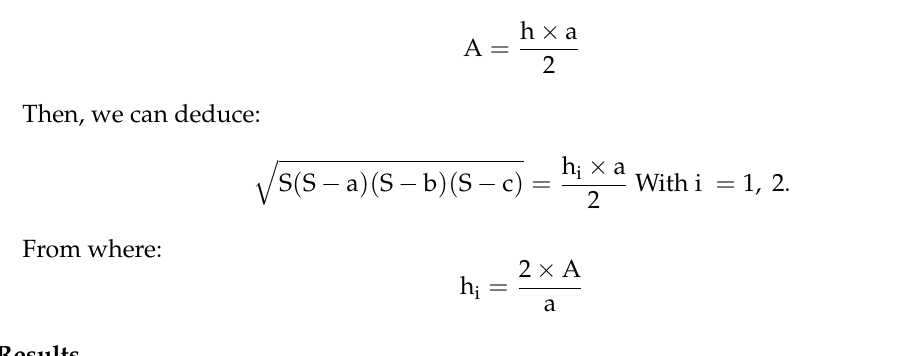
( b ) Figure 8. Detection of the endpoints and bifurcation points: ( a ) Endpoints; ( b ) Bifurcation points. The Douglas-Peucker algorithm reduces the data storage amount and the number of points from a given line, while maintaining its principal geometrical and topological properties. The data compression ratio (DCR) (Figure 9) is defined as follows: (cid:1830)(cid:1829)(cid:1844) = ((cid:1840) − (cid:1866)) (cid:1866)